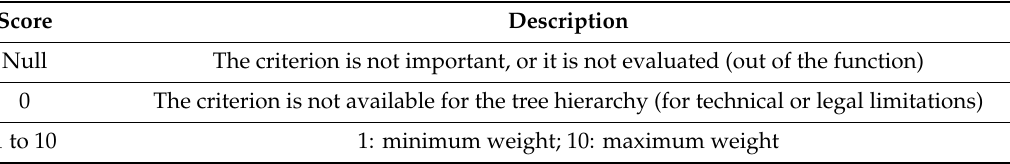
Table 3. Utility function for the establishment of weights for criteria.